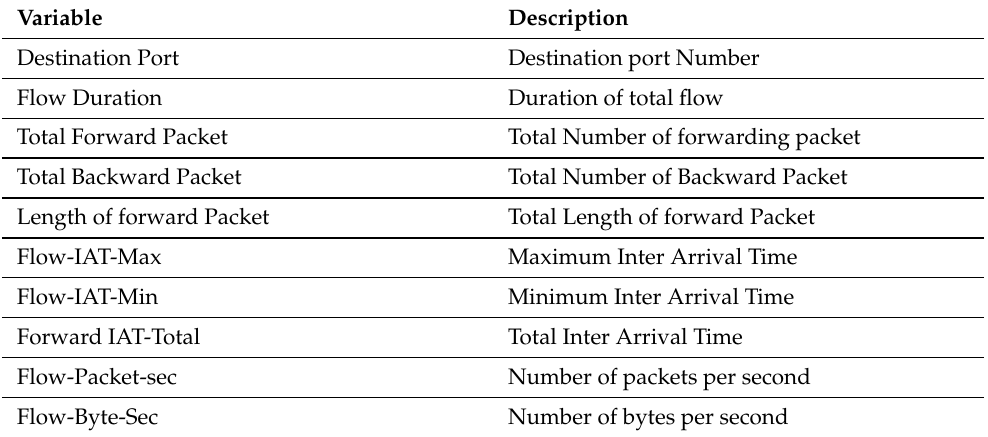
Table 2. Description of a few attributes of the dataset.